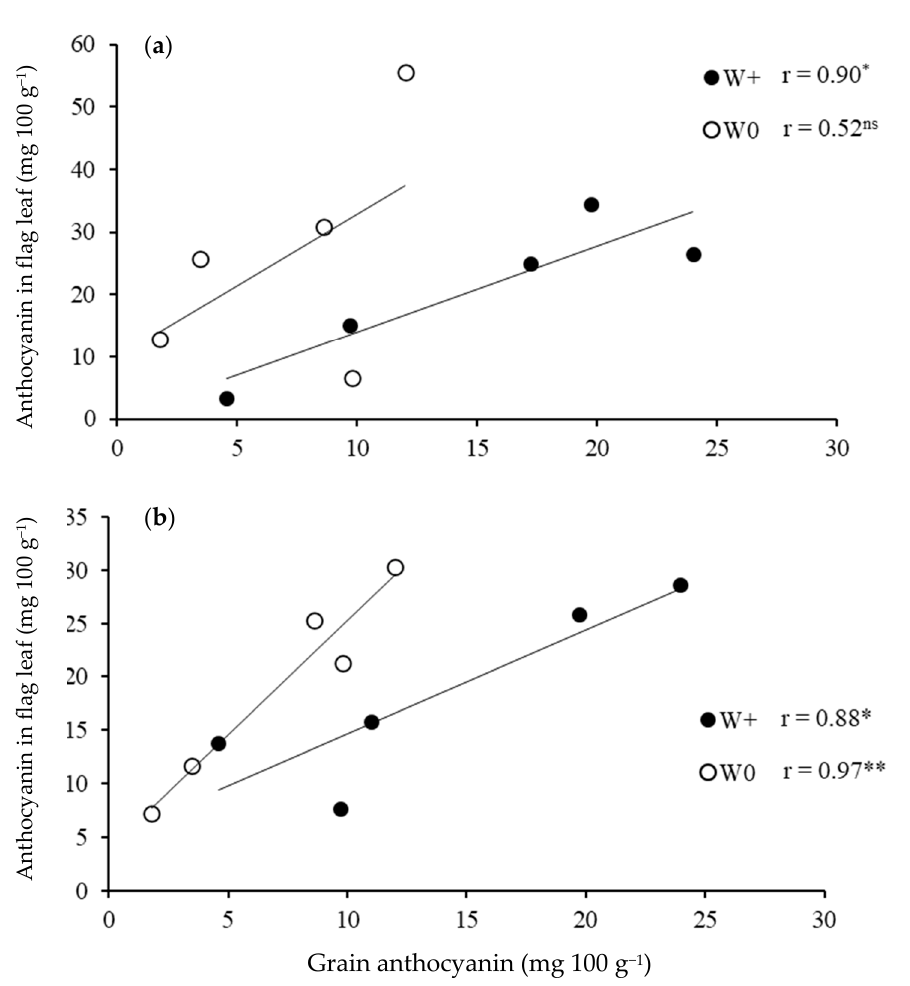
Figure 4. Correlation between grain anthocyanin and anthocyanin in leaves at booting ( a ) and flowering ( b ) under waterlogged (W+) and aerobic conditions (W0). Each data point is the mean of 3 replications. (Significant correlation at p < 0.05 * and p < 0.01 **).